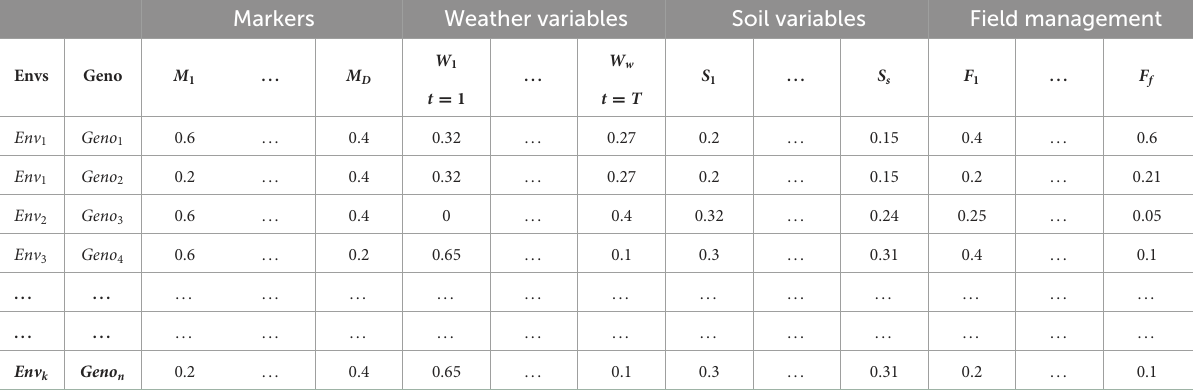
TABLE 2 An example of genotyped and environmental data after pre-processing in a tabular format. Markers Weather variables Soil variables Field